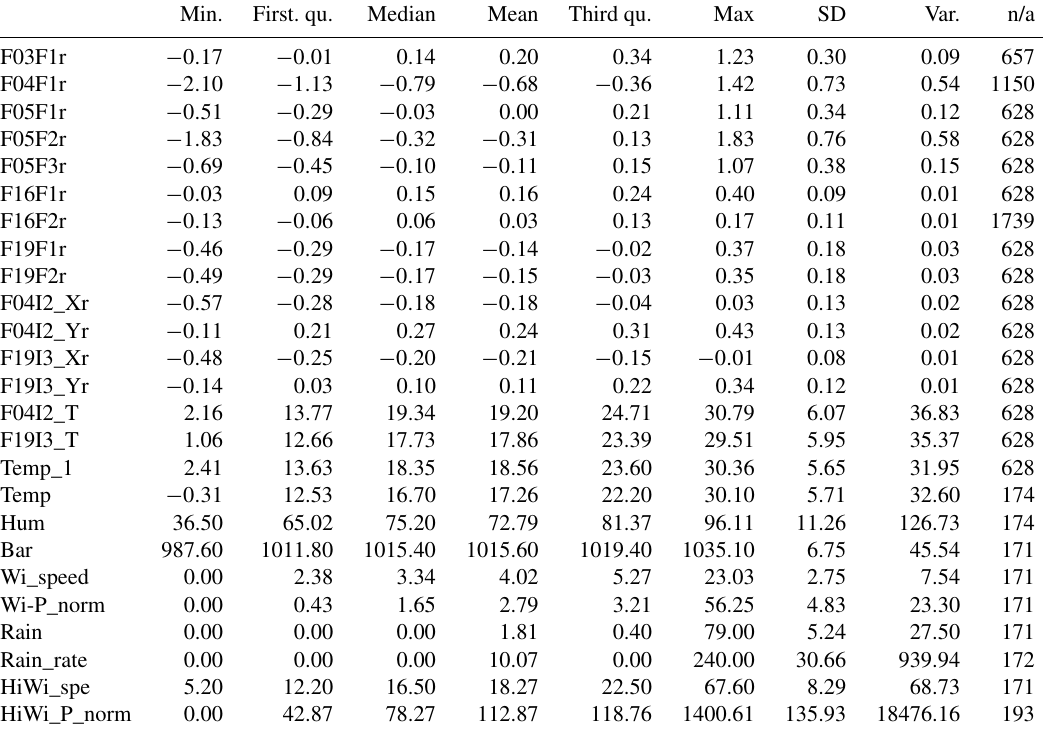
Table 10. Descriptive statistics of daily tuff deformation and meteorological data. Min. First. qu. Median Third qu.